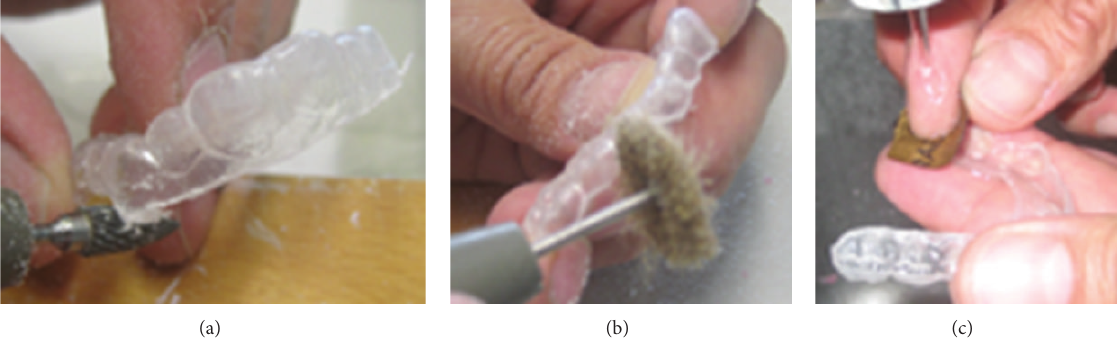
Figure 5: The resin mouthguard is well